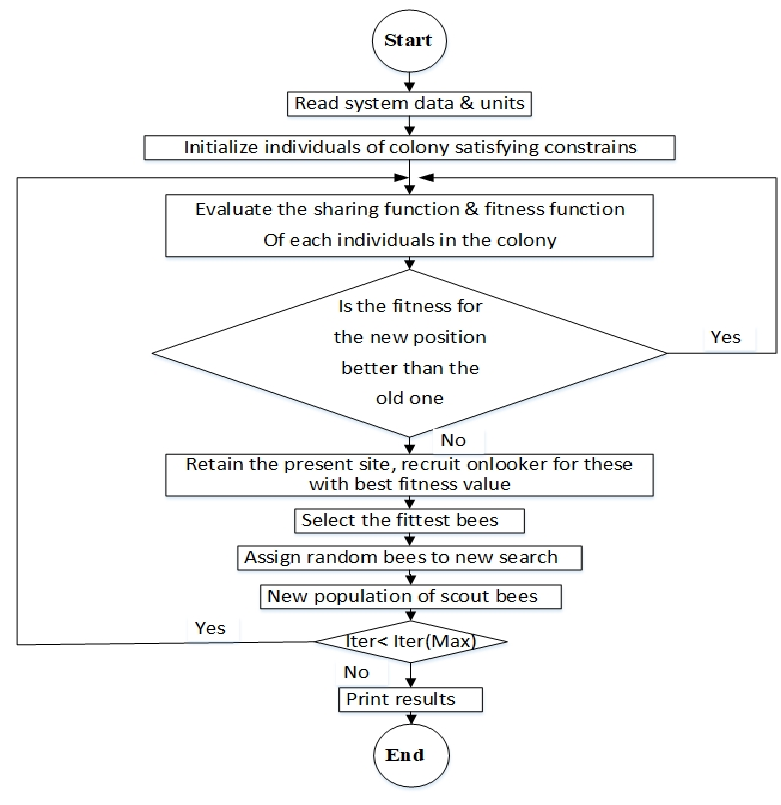
Figure 4. ABC flow chart.